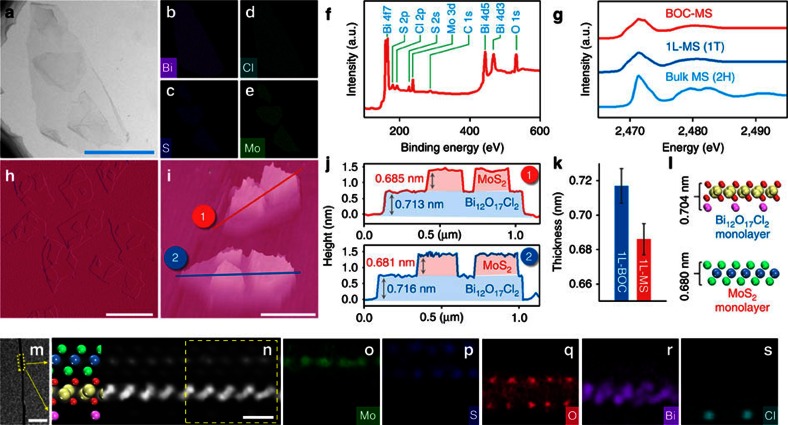
Characterizations of the Janus bilayer junctions assembled by
Bi12O17Cl2 and MoS2 monolayers
(BOC-MS).(a) Top-view TEM image, (b–e) elemental mapping
images, (f) XPS spectra, (h,i) AFM images, side-view
TEM image (m) and atomic-resolution HAADF-STEM image (n), and
(o–s) the corresponding EELS elemental maps of
BOC-MS. Scale bar, 500 nm, 1 μm, 500 nm,
10 nm and 5 Å, in
a,h,i,m,n, respectively. (g) S
K-edge XANES spectra of BOC-MS, 1L-MS and bulk MS. (j) Height
profiles along the lines in i. (k) Comparison of the average
thicknesses of 1L-BOC and 1L-MS in BOC-MS. The error bars in k
represent the s.d. of over 100 independent AFM measurements. (l) The
theoretical thicknesses of MoS2 and
Bi12O17Cl2 monolayers.